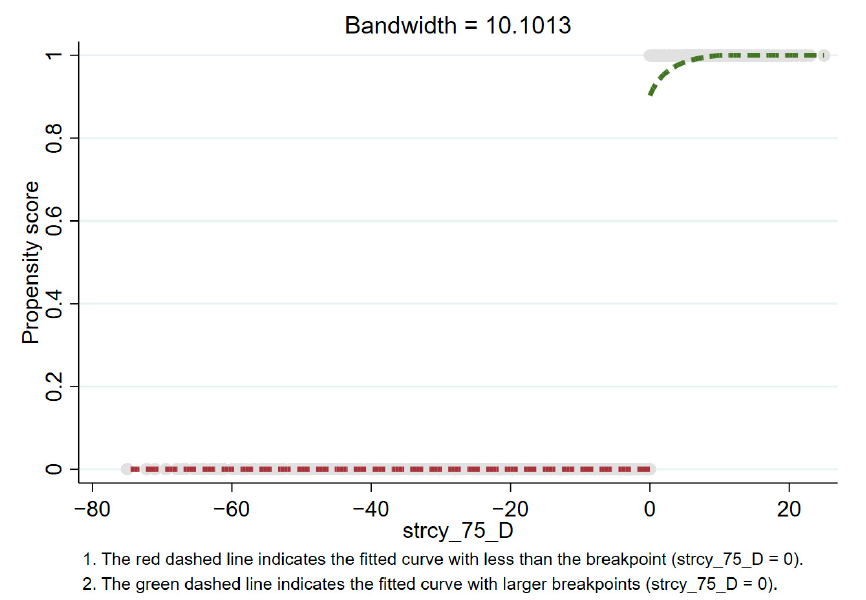
Figure 6. Propensity score at stringency = 75 (based on fuzzy breakpoint regression).